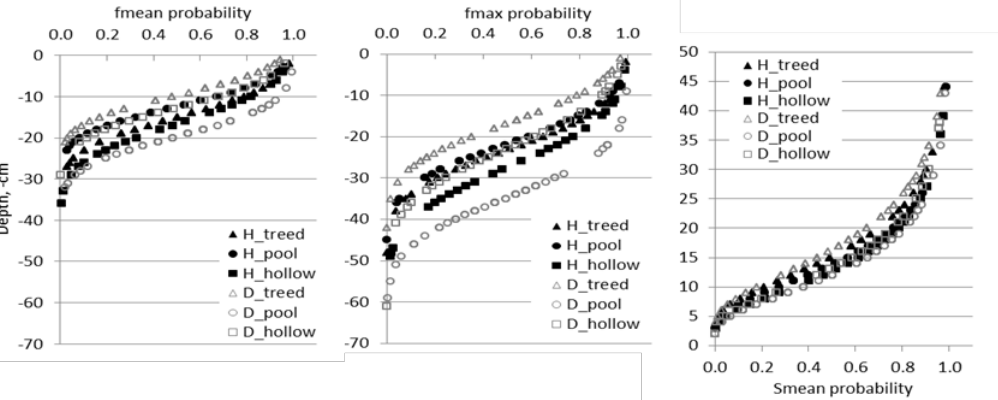
Figure 7. PBPs of the 50-year soil frost (f and depression (D) microforms of the Männikjärve treed, ridge-pool and ridge-hollow ecotopes.